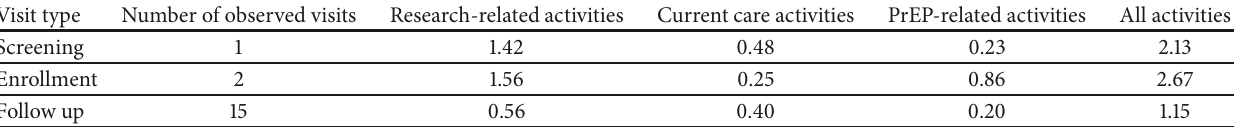
Table 1: Average time (in hours) required to conduct intervention visits by type and activity.